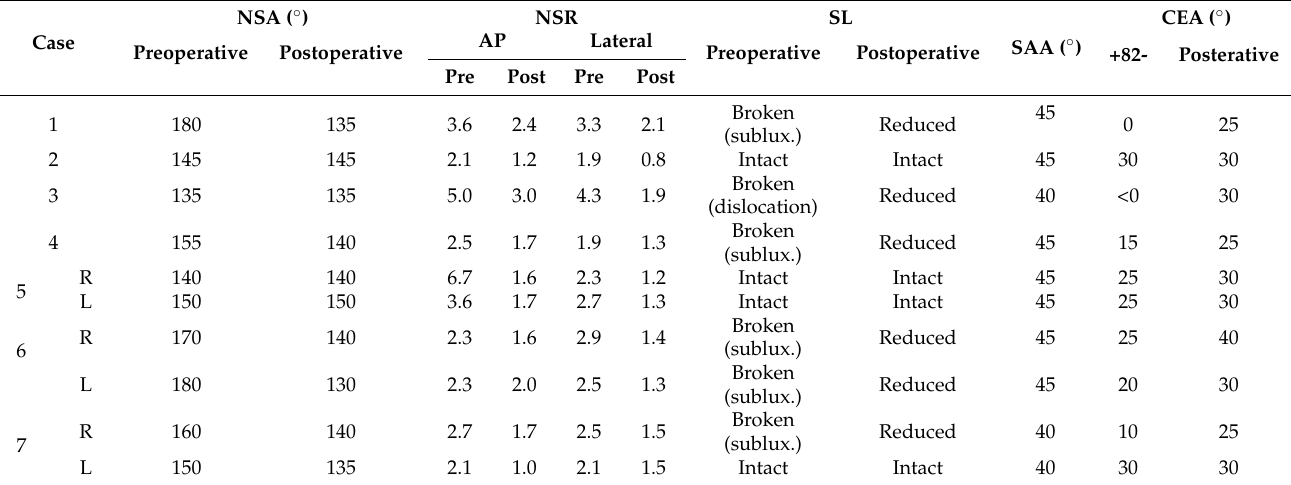
Table 3. Changes in radiographic